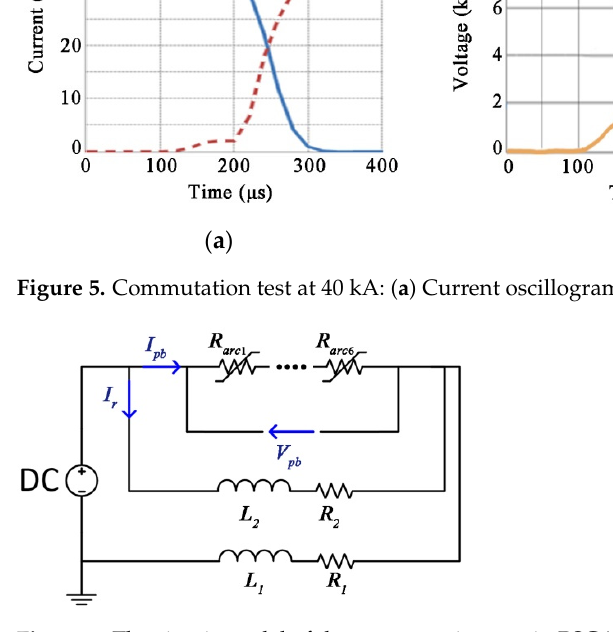
Figure 6. The circuit model of the commutation test in PSCAD.